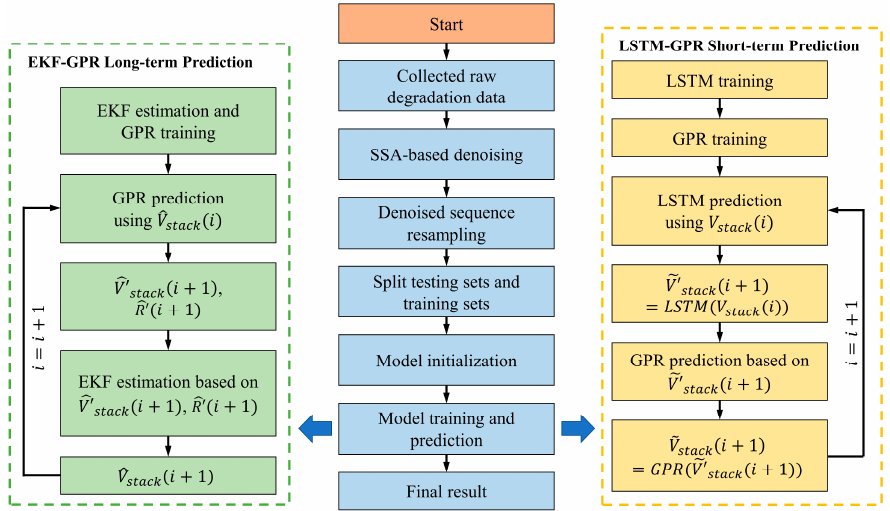
Figure 4. The diagram of the hybrid performance degradation prediction method.